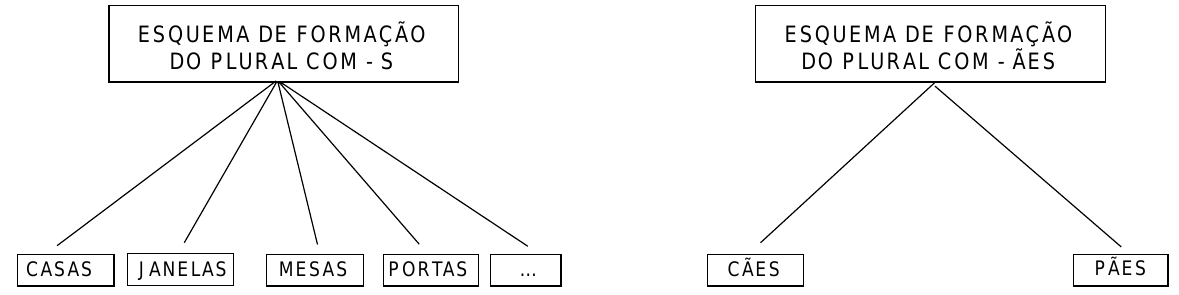
Figura 1 . Relação esquema-instância na formação do plural em